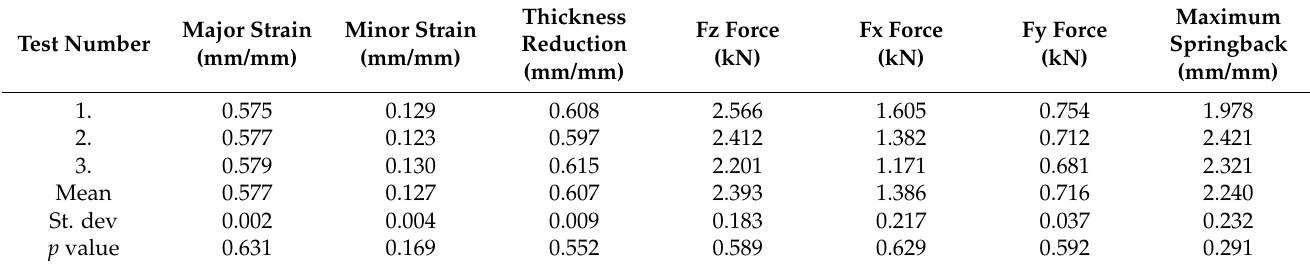
Table 10. Results for double side welded blanks processed by SPIF in truncated pyramid